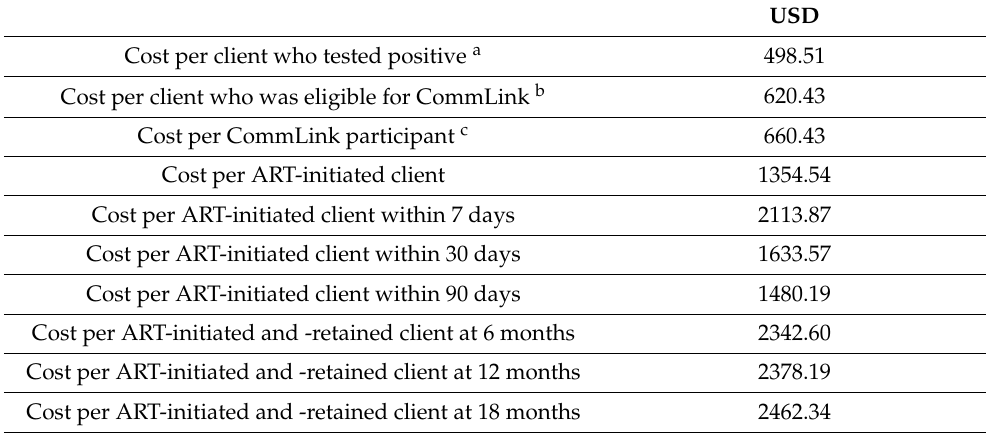
Table 2. Costs per outcome (in 2018 USD).